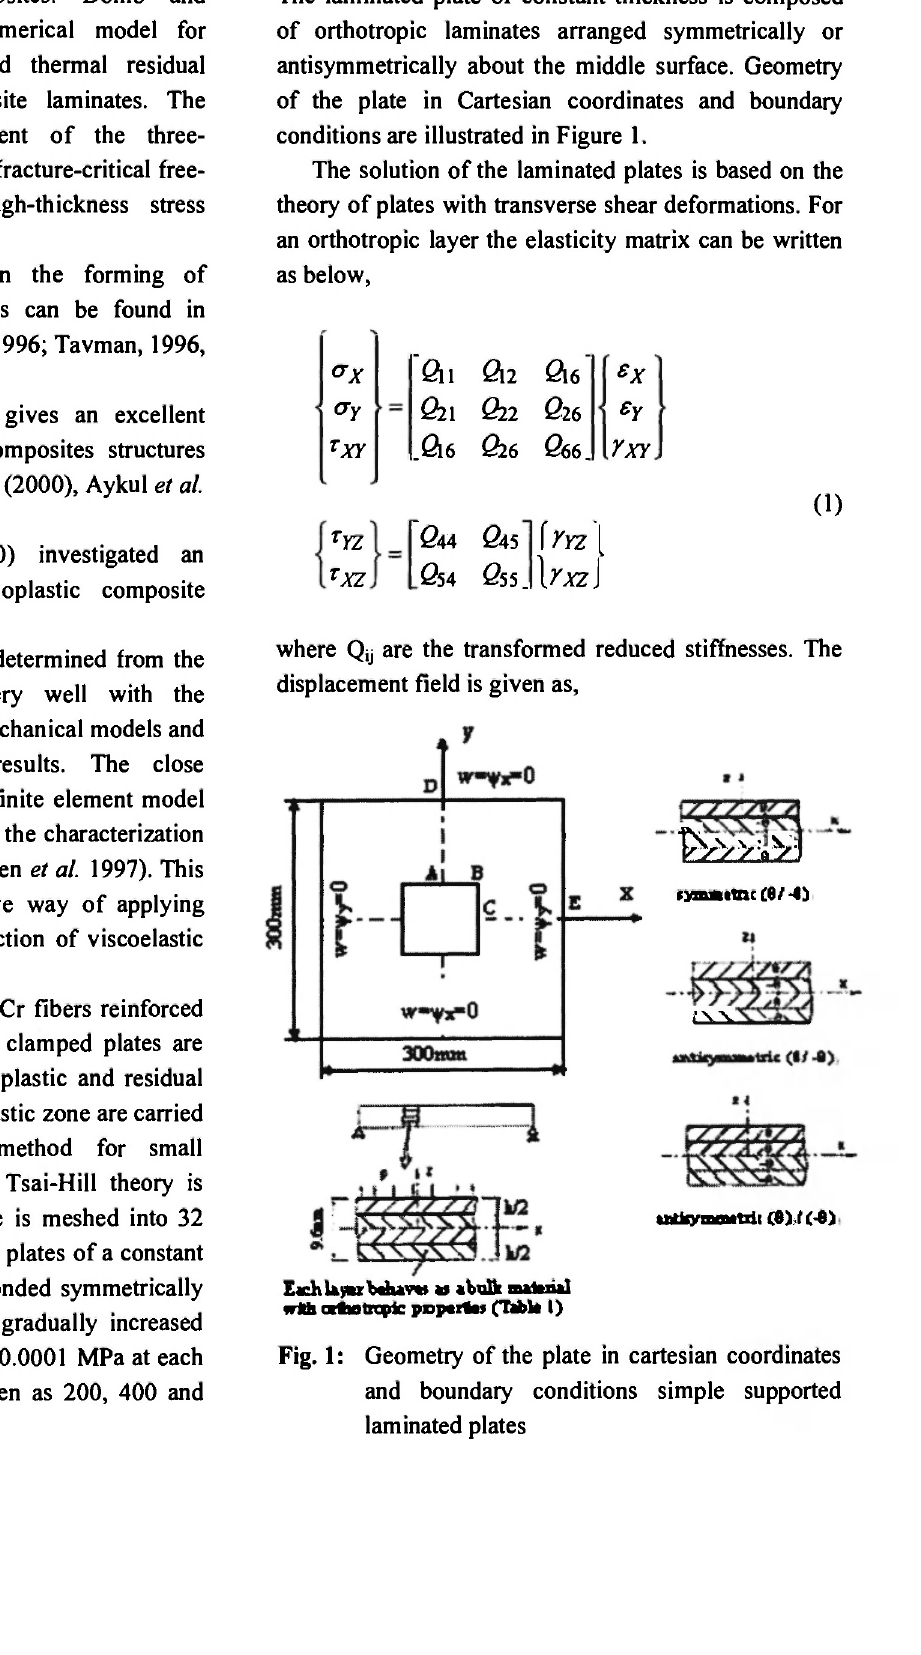
Fig. 1: Geometry of the plate in cartesian coordinates and boundary conditions